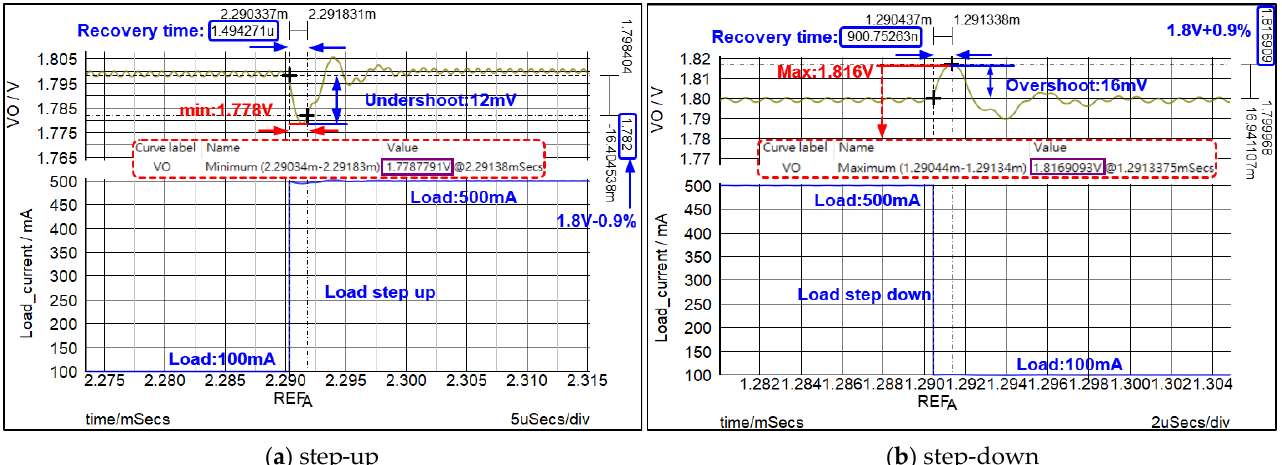
Figure 7. The recovery times for load current transition between 100 – 500 mA. ( a ) step-up. ( b ) step- down.